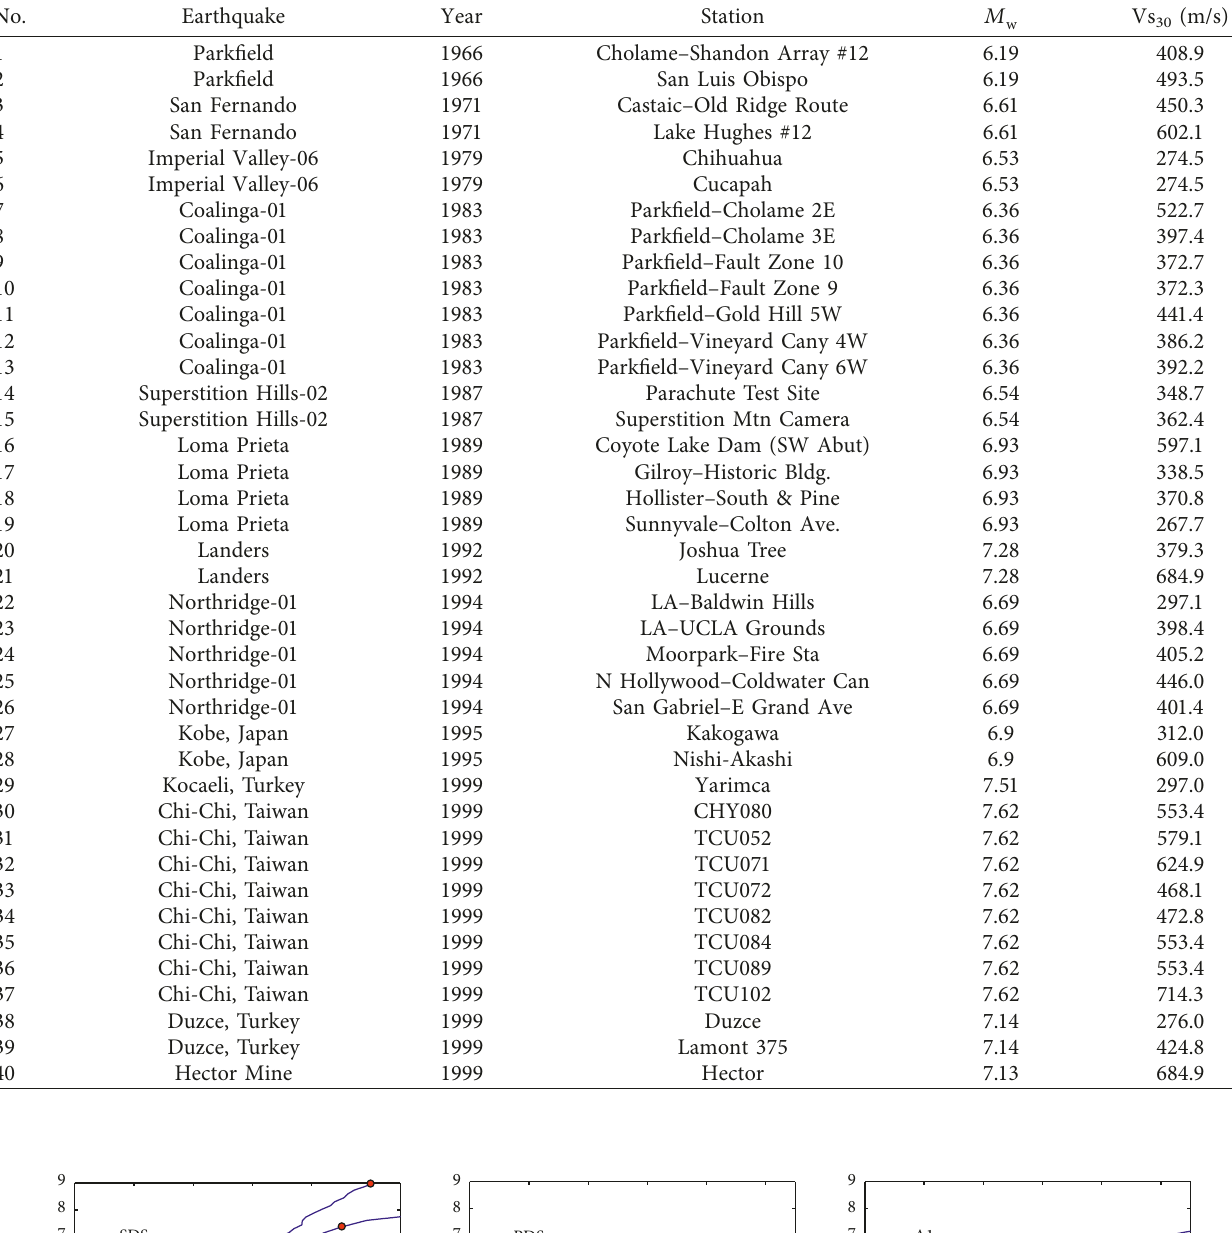
Table 3: Basic information of the ground motion